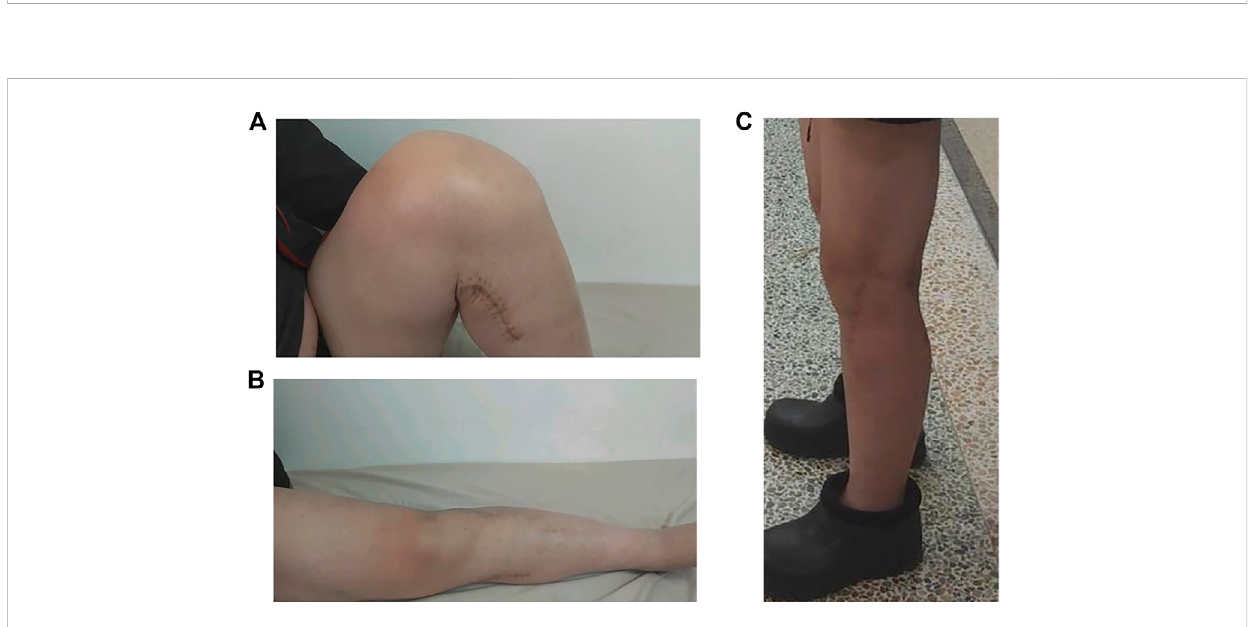
Functionalrecoveryofthekneejoint8monthspostoperativelyFlexion (A) andextension (B) oftheaffectedlimb,andfullweight-bearingwalking (C)